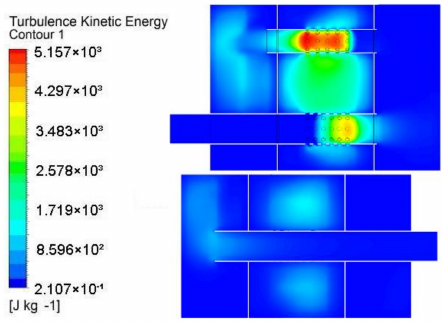
Figure 11. Contour of turbulence kinetic energy in the cross section of the